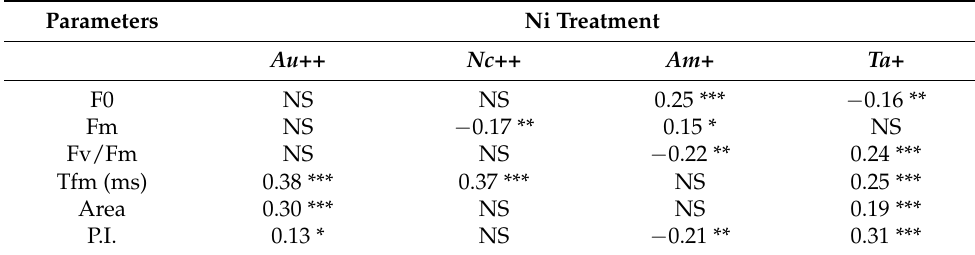
Table 3. Spearman’s rank correlations coefficients between Ni concentration and fluorescence pa- rameters of test species (F0: dark level fluorescence, Fm: maximum fluorescence, Fv/Fm: maximum efficiency of PSII, Tfm: time (ms) to reaching Fm, P.I. Performance Index). n = 300 each species.